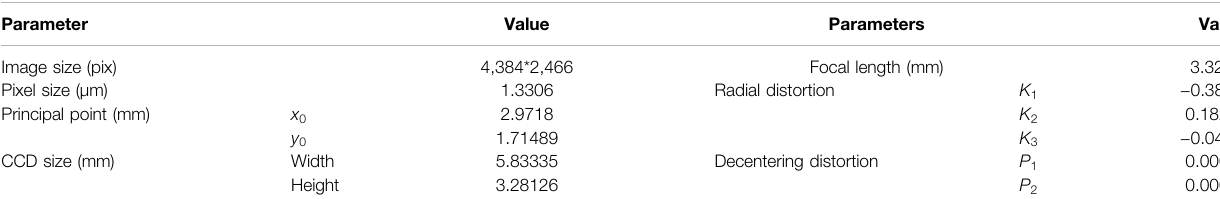
TABLE 1 | Calibrated parameters for camera on the UAV.